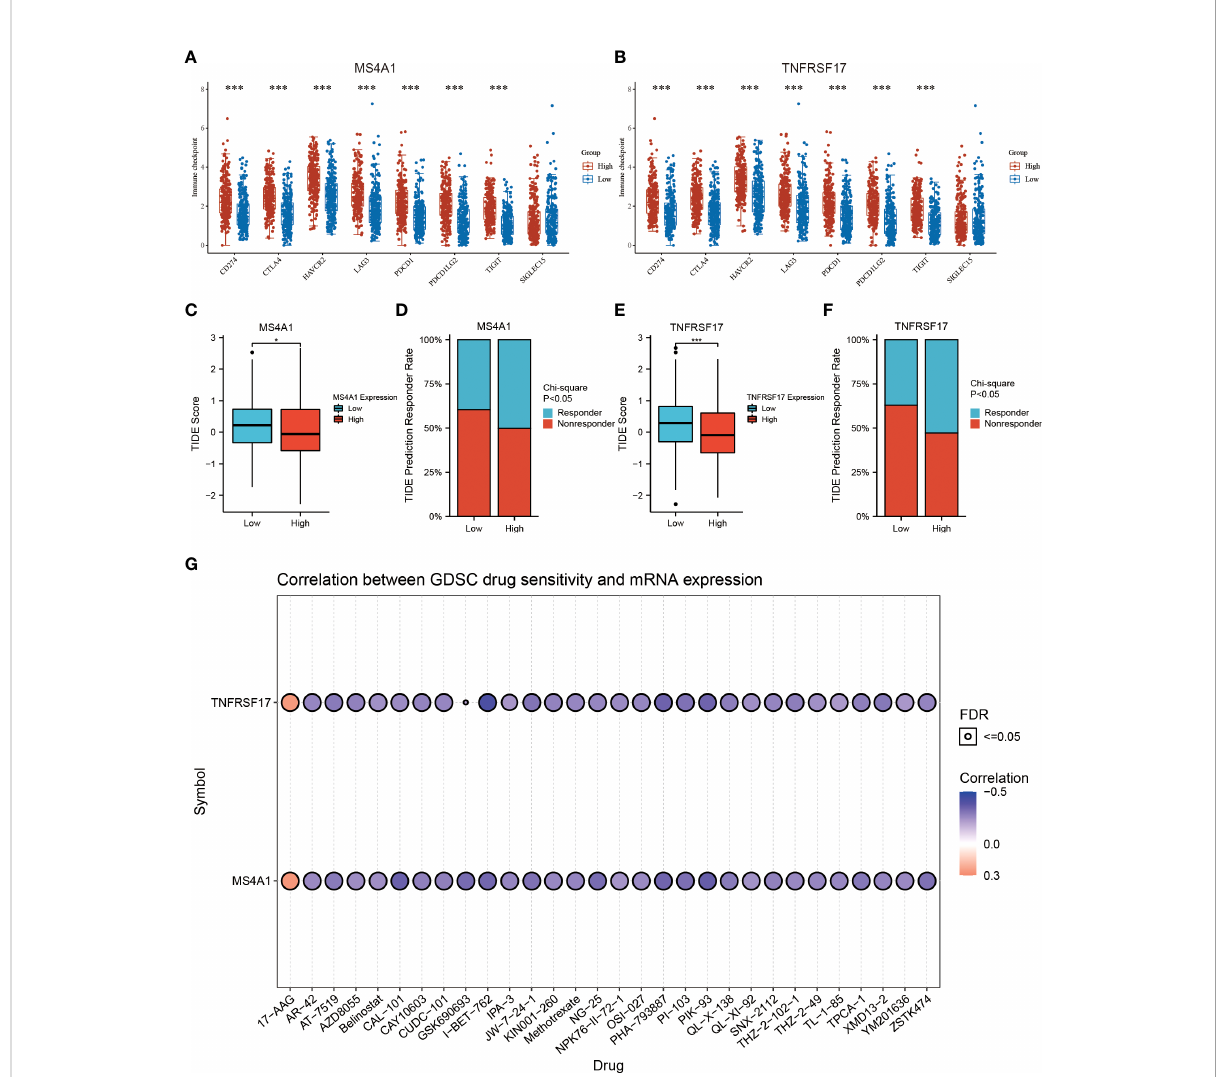
FIGURE 6 MS4A1 and TNFRSF17 are associated with CC drug sensitivity. (A) Differences in the expression of common immune checkpoints between the high- and low-MS4A1-expression groups. (B) Differences in the expression of common immune checkpoints between the high- and low- TNFRSF17-expression groups. (C) Differences in TIDE scores between the high- and low-MS4A1-expression groups. (D) Differences in response rates predicted based on TIDE scores between the high- and low-MS4A1-expression groups. (E) Differences in TIDE scores between the high- and low-TNFRSF17-expression groups. (F) Differences in response rates predicted based on TIDE scores between the high- and low-TNFRSF17- expression groups. (G) Correlation between drug sensitivity and gene expression. *, <0.05; ***,